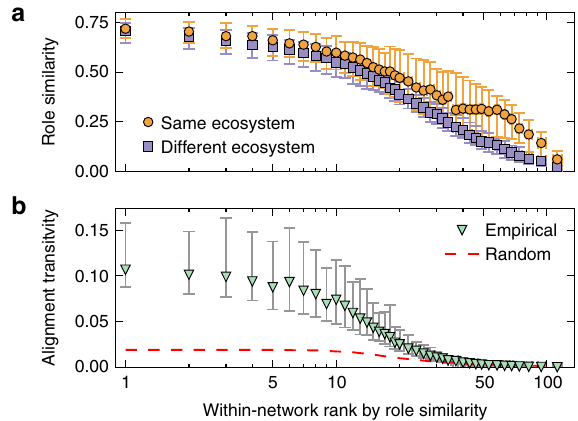
Fig. 3 Ranking of species from our dataset of 411 food webs based on the average similarity between their role and the roles of the species to which they are paired across all 84,255 alignments. The top panel a shows the observed role similarity for all species when compared to food webs from either the same (circles) or different (squares) ecosystem types. The bottom panel b shows the alignment transitivity observed for all species across all food webs. The red dotted line represents the expected alignment transitivity for shuf fl ed alignments, where the number of pairings per alignment was maintained. In both panels, every point indicates the median across at least 250 species with the exception of the last point which is the median across 30 species, and the error bars characterize the interquartile